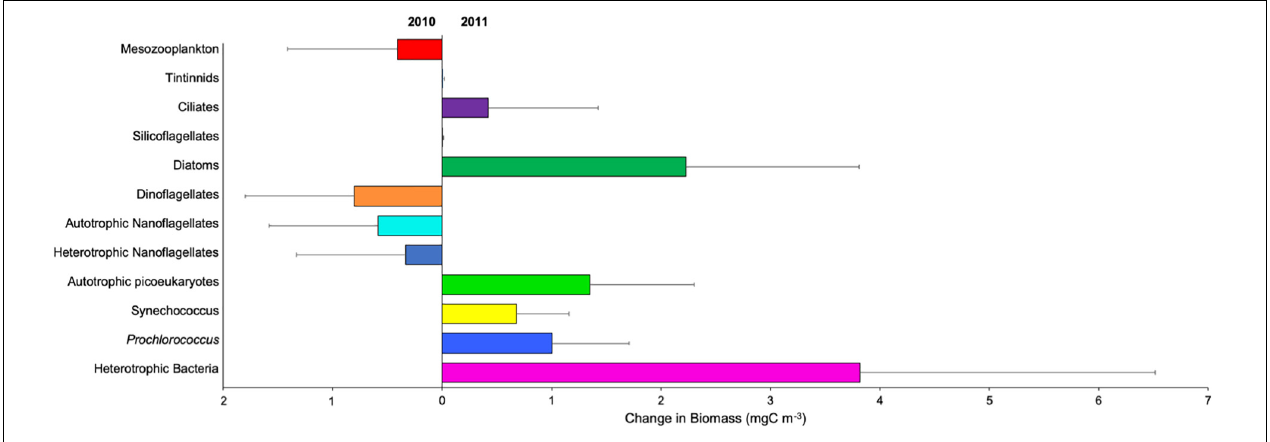
FIGURE 9 | Changes in biomass (mgC m − 3 ) ( ± SE) of autotrophic picoeukaryotes ( (cid:4) ), Synechococcus ( (cid:4) ), Prochlorococcus ( (cid:4) ), autotrophic nanoflagellates ( (cid:4) ), heterotrophic nanoflagellates ( (cid:4) ), heterotrophic bacteria ( (cid:4) ), diatoms ( (cid:4) ), dinoflagellates ( (cid:4) ), silicoflagellates ( (cid:4) ), ciliates ( (cid:4) ), tintinnids ( (cid:4) ), and mesozooplankton ( (cid:4) ) between 2010 and 2011 years. Right values indicate more biomass in 2011, while left values indicate more biomass in 2010. TABLE 3 | Mortality (m) and growth ( µ ) rates (d − ) of total phytoplankton (Chla), autotrophic picoeukaryotes (APE), Synechococcus (Syn), Prochlorococcus (Prochl), autotrophic nanoflagellates (AN), heterotrophic bacteria (HB) and heterotrophic nanoflagellates (HN) for each dilution experiment.